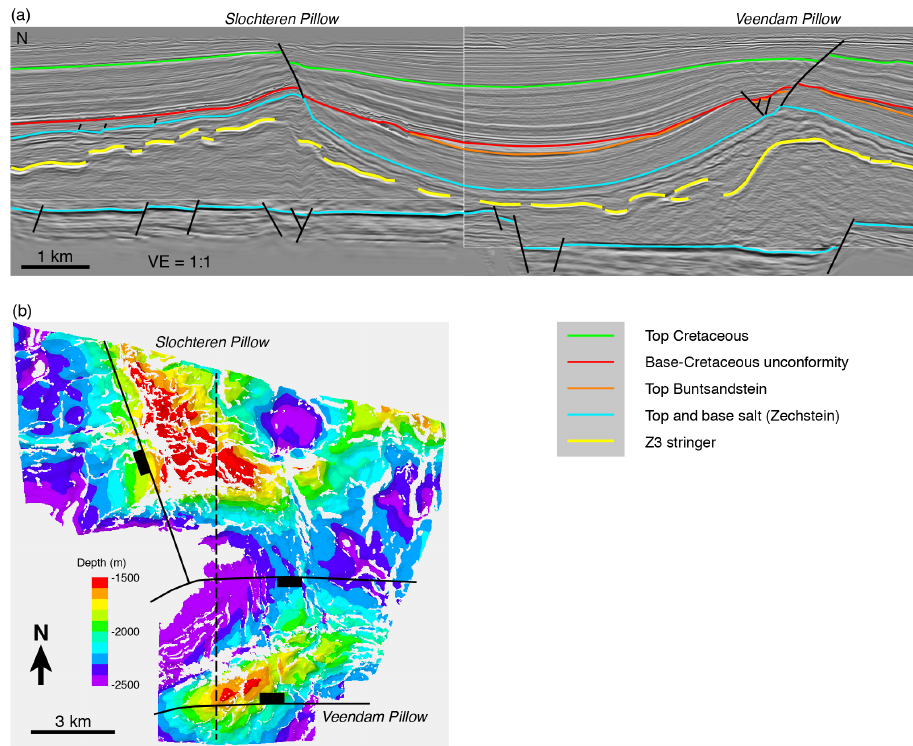
Figure 18. The Slochteren and Veendam pillows on the Groningen High, the Netherlands (adapted from Raith et al., 2016): (a) 3-D depth- migrated seismic profile (vertical exaggeration 1 : 1, location shown by dashed line on map); (b) structure map of the Z3 stringer, with white representing gaps in the interpreted layer (gaps between yellow stringers on the seismic), and pre-salt extensional faults in